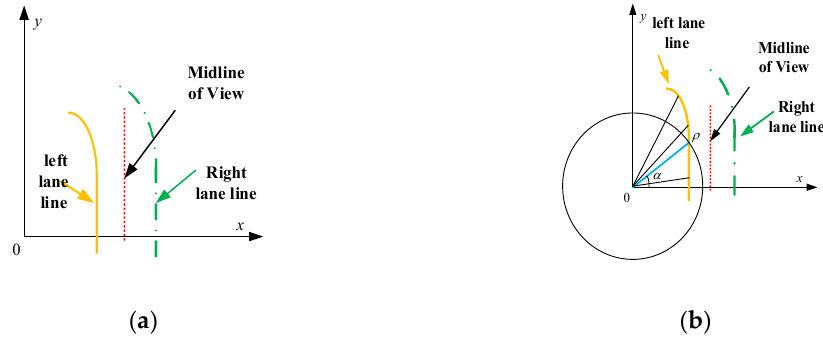
Figure 11. Polar and rectangular coordinates: ( a ) Rectangular coordinates; ( b ) Polar coordinates.